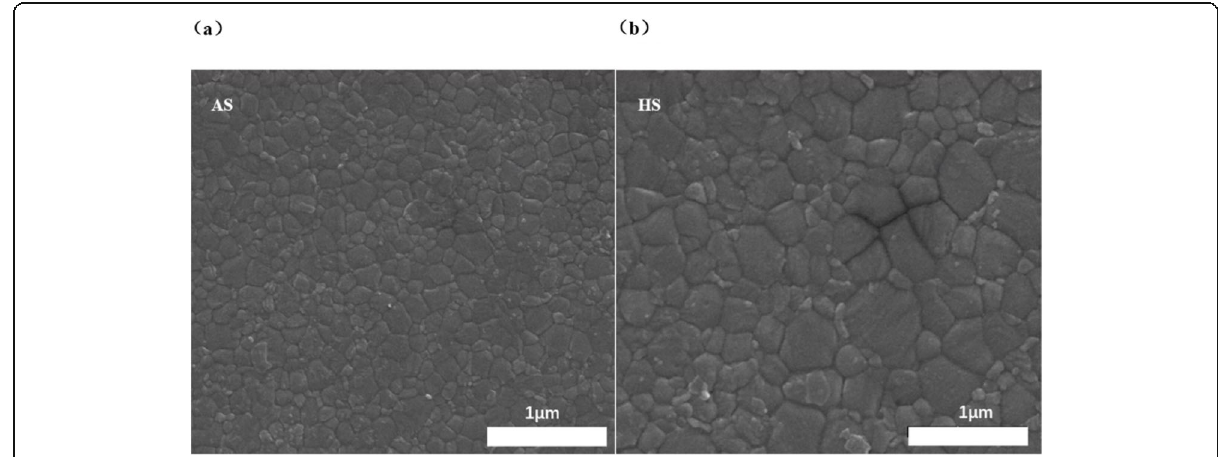
Fig. 4 SEM images of perovskite prepared with AS method ( a ) and HS method ( b